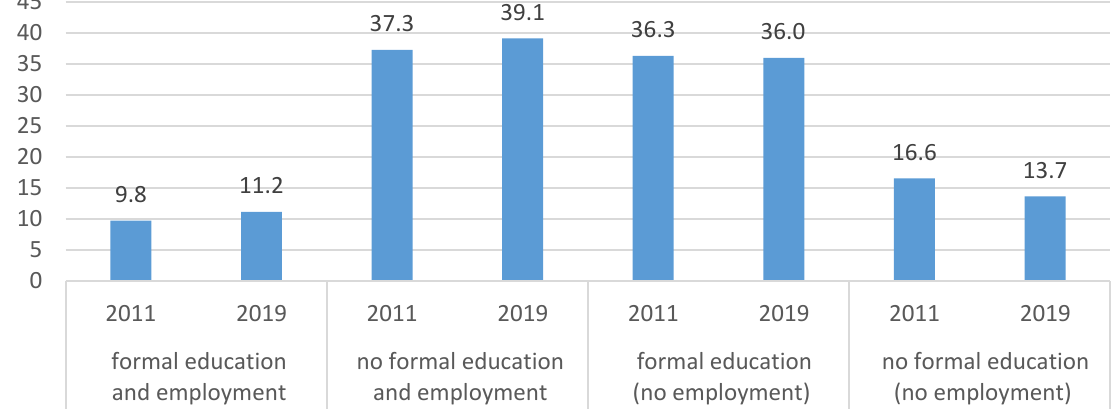
Figure 1. Young people by education and employment status, EU (%